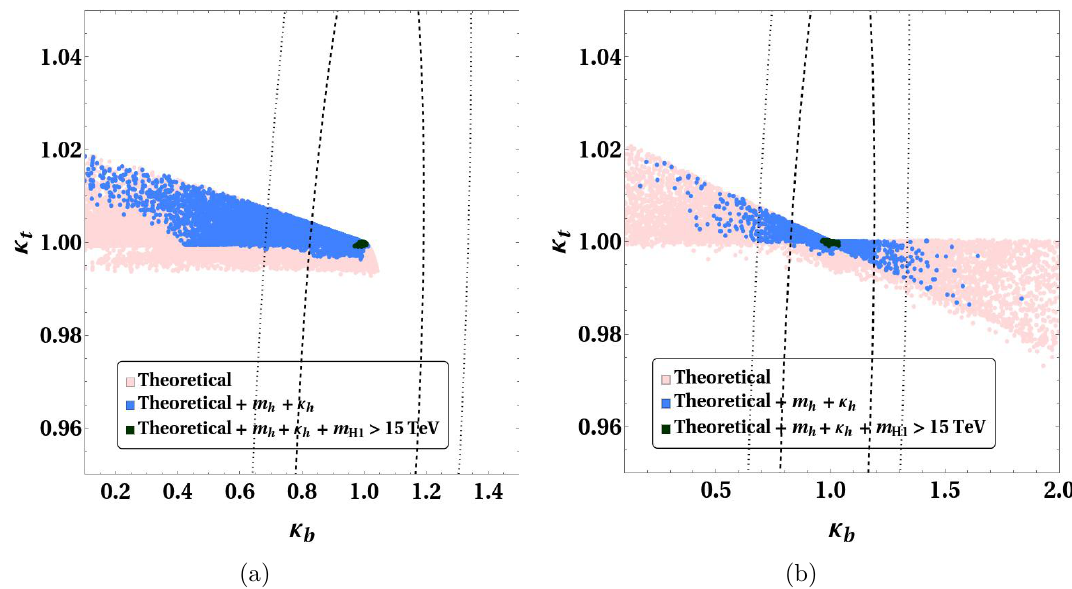
Figure 5. Predictions for κ b and κ t for (a) simple and (b) generic basis with random values of quartic couplings in the ranges given by eqs. (5.2) and (5.5) respectively. Additionally, p and q are varied logarithmically in the range [0 . 1 , 10] . The pink points satisfy the theoretical constraints, the blue points satisfy the additional m and κ constraints, and dark green points also satisfy h h constraint on heavy Higgs mass m 15 H 1 >